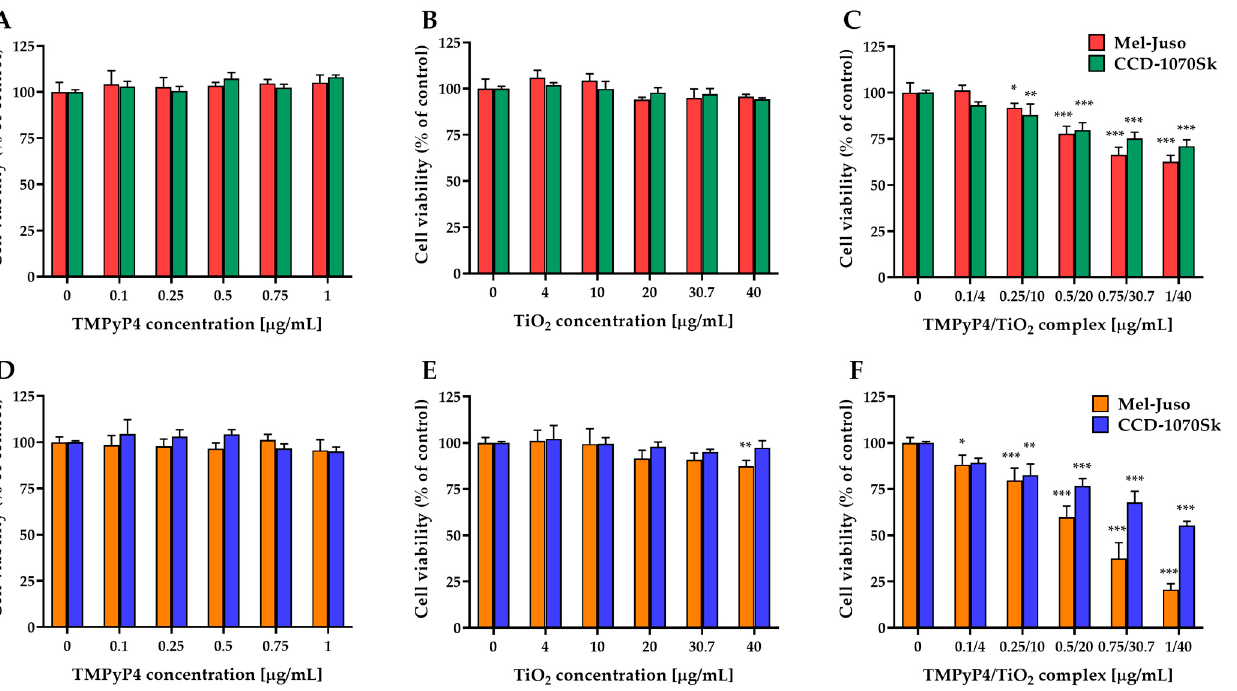
Figure 7. Effect of TMPyP4, TiO 2 NPs, and TMPyP4/TiO 2 complex on the metabolic activity/cell viability of cells. The graphs present the relative mitochondrial dehydrogenase activity of treated human Mel-Juso and CCD-1070Sk cells under dark ( A – C ) and light-irradiation conditions ( D – F ). Untreated cells (0 µ g/mL) were used as a control. Results (control vs. sample) were significant at p < 0.05 (*), p < 0.01 (**), and p < 0.001 (***). Error bars reflect the standard